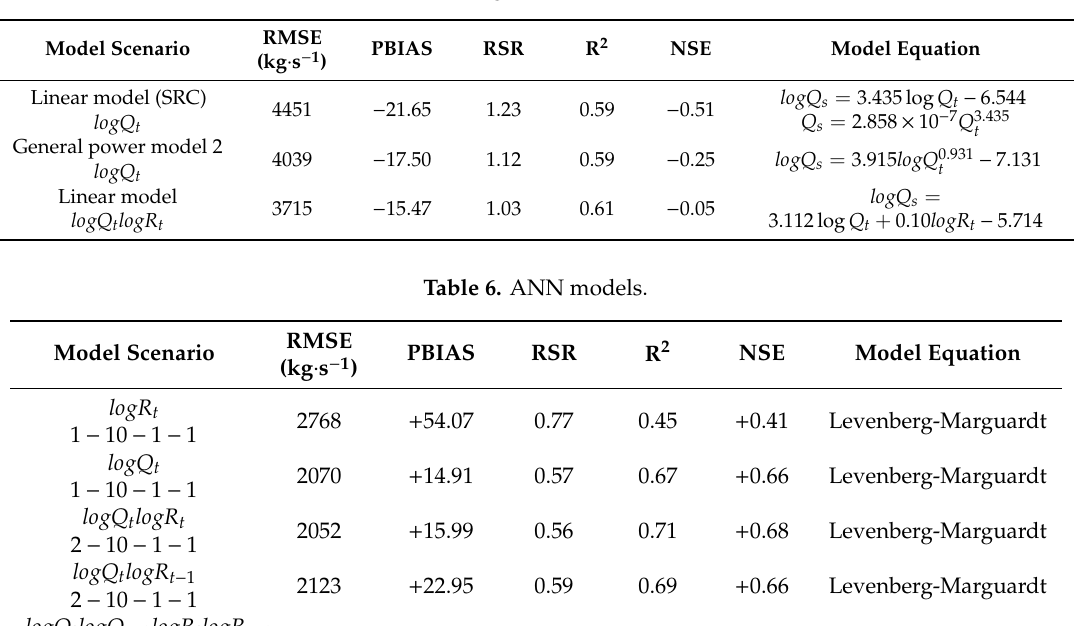
Table 5. Log transform models.